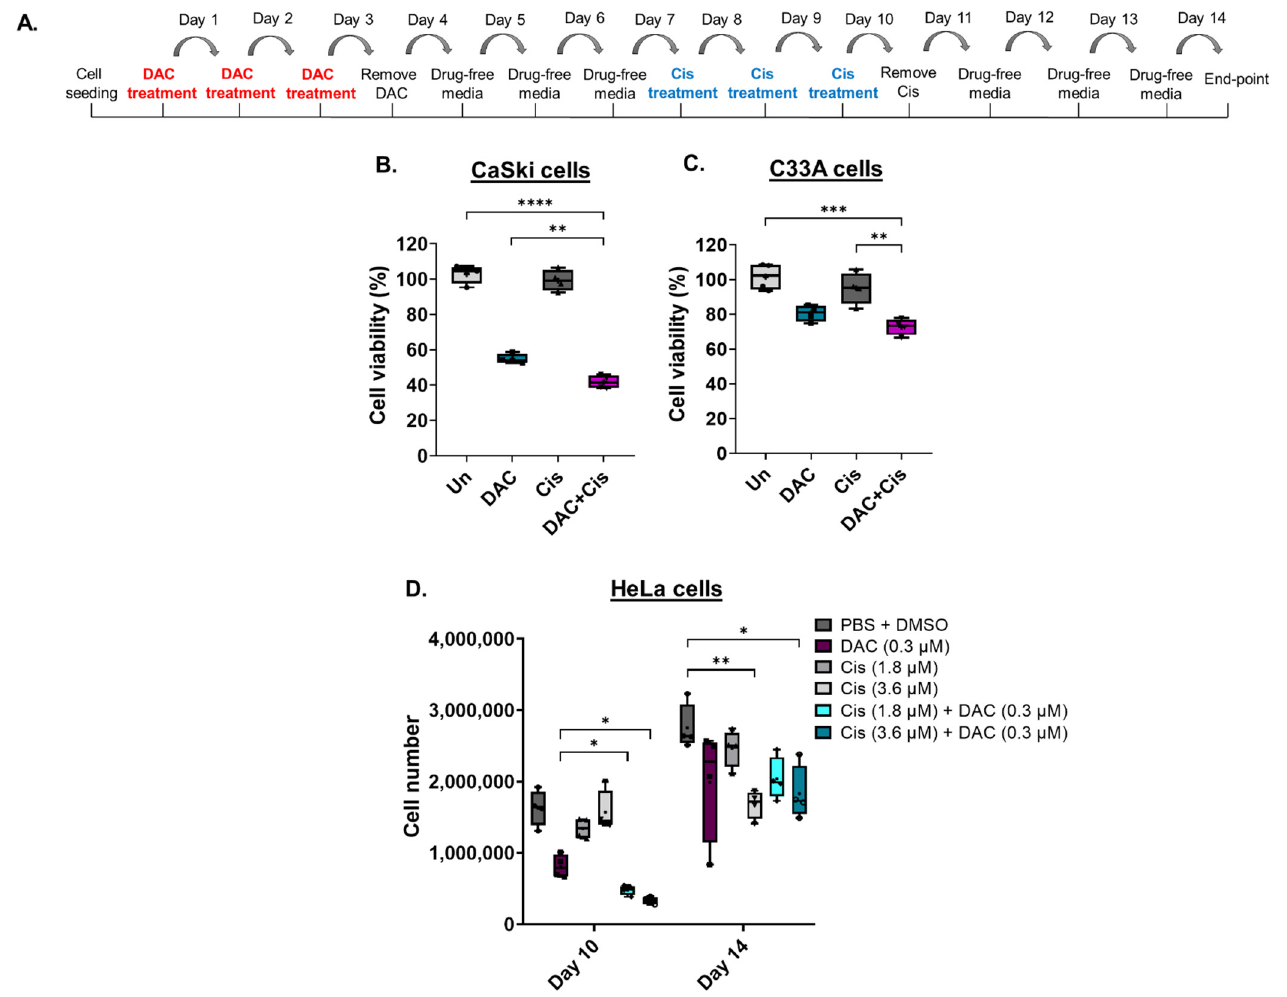
Figure 4. Low-dose DAC treatment sensitizes CC cells to cisplatin. ( A ) Timeline of DAC treatment (coloured in red) at 0.3 µ M, 72 h followed by treatment with cisplatin (coloured in blue) at 0.6 µ M, 72 h. Cells were harvested at 4 days after cisplatin treatment. Cell viability analysis of CaSki ( B ) and C33A ( C ) cells in response to the combination treatment of DAC (0.3 µ M, 72 h) followed by cisplatin (0.6 µ M, 72 h). Statistical analysis was performed using one-way ANOVA (Kruskal–Wallis test) (** p < 0.01, *** p < 0.001, **** p < 0.0001). ( D ) HeLa cells were treated with DAC at 0.3 µ M, 72 h, followed by cisplatin treatment at 1.8 µ M or 3.6 µ M for 72 h. Cell numbers were assessed using a cell counter at the indicated time points of treatment. The following treatment groups were included in the experiment: DAC alone (0.3 µ M, 72 h); cisplatin alone (1.8 µ M, 72 h or 3.6 µ M, 72 h); DAC treatment followed by cisplatin at 1.8 µ M, 72 h or 3.6 µ M, 72 h; PBS + DMSO treated cells used as the vehicle control. Cell number of adherent HeLa cells of all treatment conditions were counted at day 10 and day 14, as indicated in the timeline ( A ). The data presented are a representative repeat of three independent experiments. The data are plotted as the median with range. The mean is also indicated by a cross (+). Statistical analysis was performed using one-way ANOVA (Kruskal–Wallis test) test (* p < 0.05, ** p <